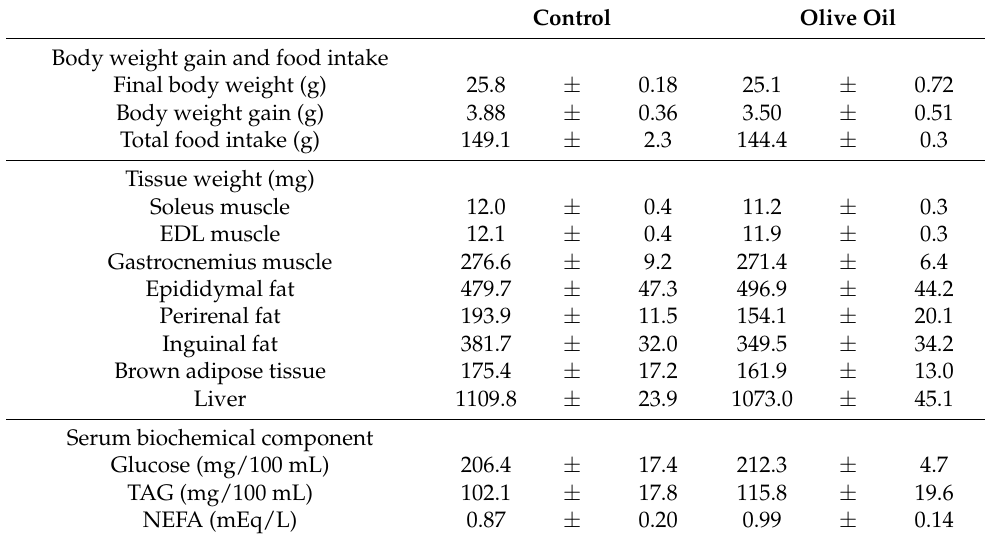
Table 4. Growth performance, tissue weights, and serum biochemical